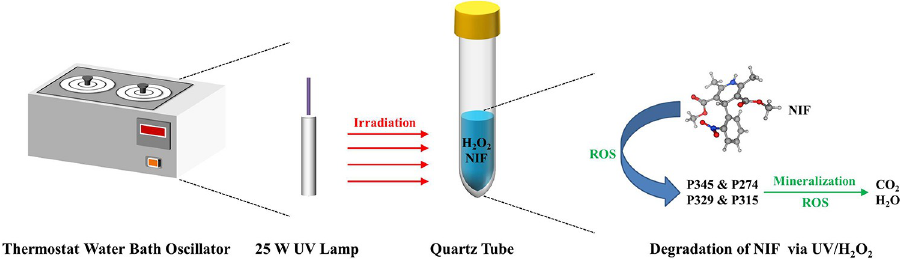
Fig 2. Experimental setup of UV/H 2 O 2